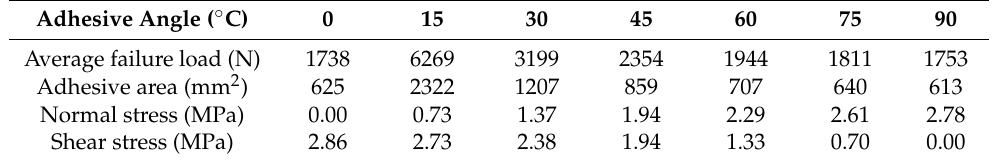
Table 7. Failure strength values of seven groups of adhesive specimens at different angles at 25 ◦ C.